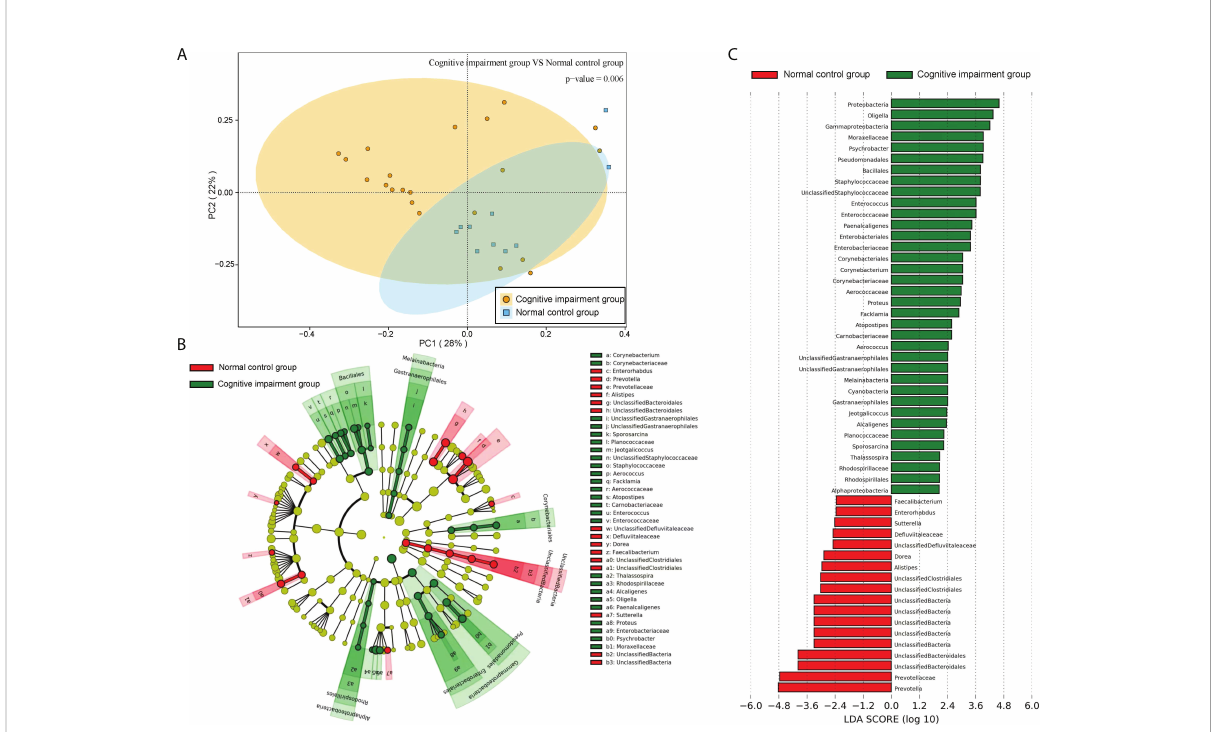
FIGURE 6 The microbiota structures of fecal samples from the normal control group and the cognitive impairment group were compared. (A) The PCA result revealed a signi fi cant difference in gut bacterial structure between the two groups. The two principal component scores accounted for 28 (PC1) and 22% (PC2) of total variations, respectively. Each symbol represents an individual sample. (B, C) The dominant fl oras of the two groups were analyzed by LEfSe (Linear discriminant analysis Effect Size). (B) Taxonomic representation of statistically and biologically consistent differences between fecal samples from the normal control group and the cognitive impairment group. Differences are represented in the color of the most abundant class (red, the normal control group; green, the cognitive impairment group; yellow, non-signi fi cant). Each circle ’ s diameter is proportional to the taxon ’ s abundance. (C) Histogram of the LDA scores computed for features differentially abundant between the two groups. The LDA threshold is